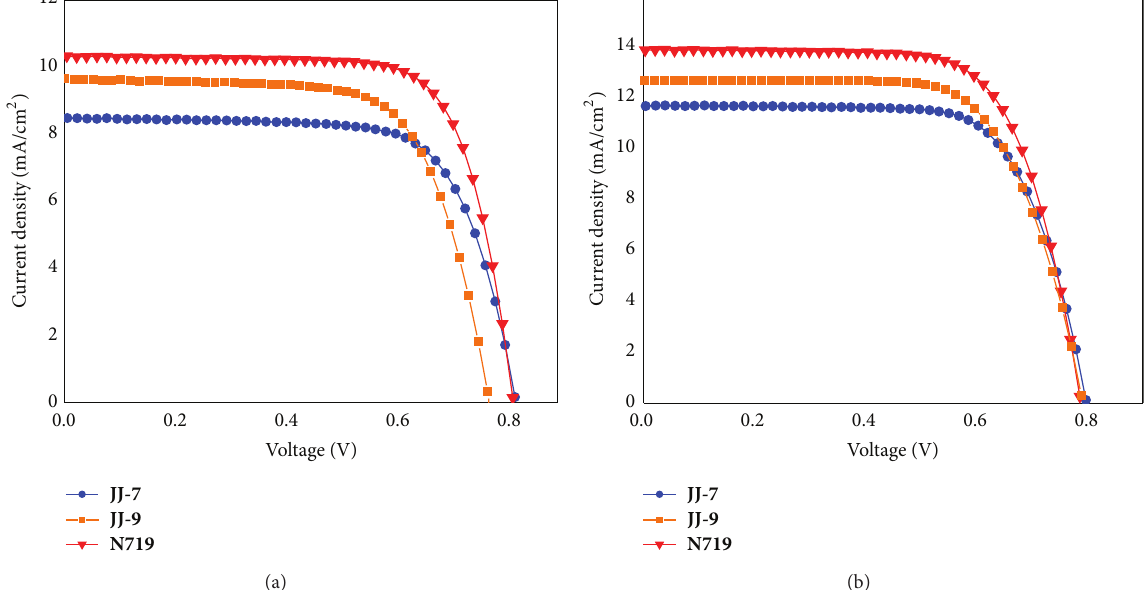
HOMO-LUMO energy gaps by electron-withdrawing abili- ties in a ligand and low molar extinction